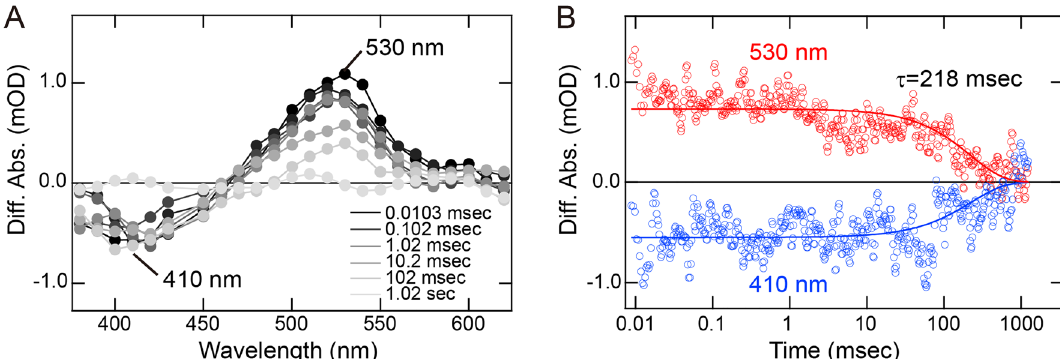
Figure 4. Photoreaction kinetics of VbACR2. ( A ) Flash-induced difference absorption spectra of VbACR2 (CEM28120) over a time range of 0.0103 ms to 1.02 s. Depletion of the original state (410 nm) and simultaneous increases in the photointermediate P 530 (530 nm) were observed. ( B ) Flash-induced kinetic data at 410 and 530 nm representing the recovery of the original state and the decay of P 530 , respectively. The plots were well- fitted to a single exponential equation, and the time constant was estimated to be 218